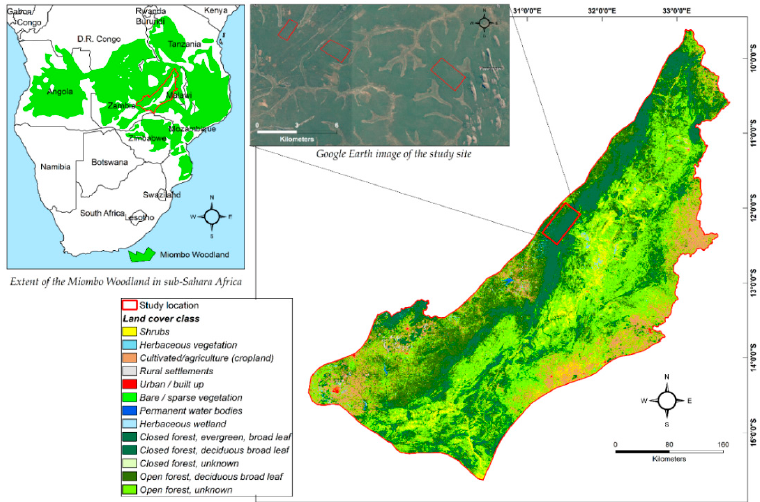
Figure 1. Extent of the Miombo Woodland in sub-Sahara Africa and the Luangwa sub-basin of the Zambezi River Basin showing the Miombo Woodland study location in Zambia. The studied Miombo Woodland is located within the central Zambezian Miombo Woodland, which is the largest Miombo subgroup. Map of Miombo Woodland adapted from the Miombo network [53]. Land cover map was adapted/based on the 2018 Copernicus global land cover map for Africa.